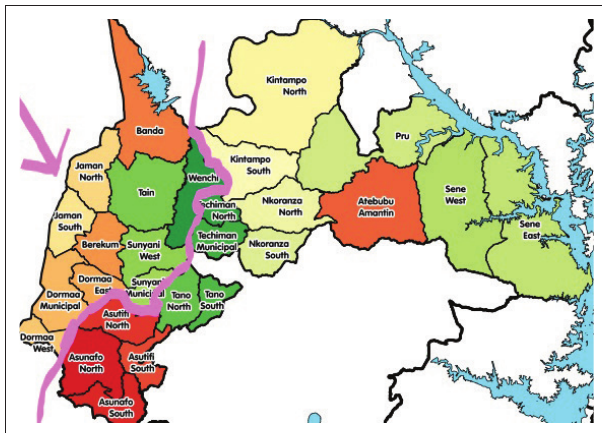
FIGURE 1: A map of Bono Region showing the administrative